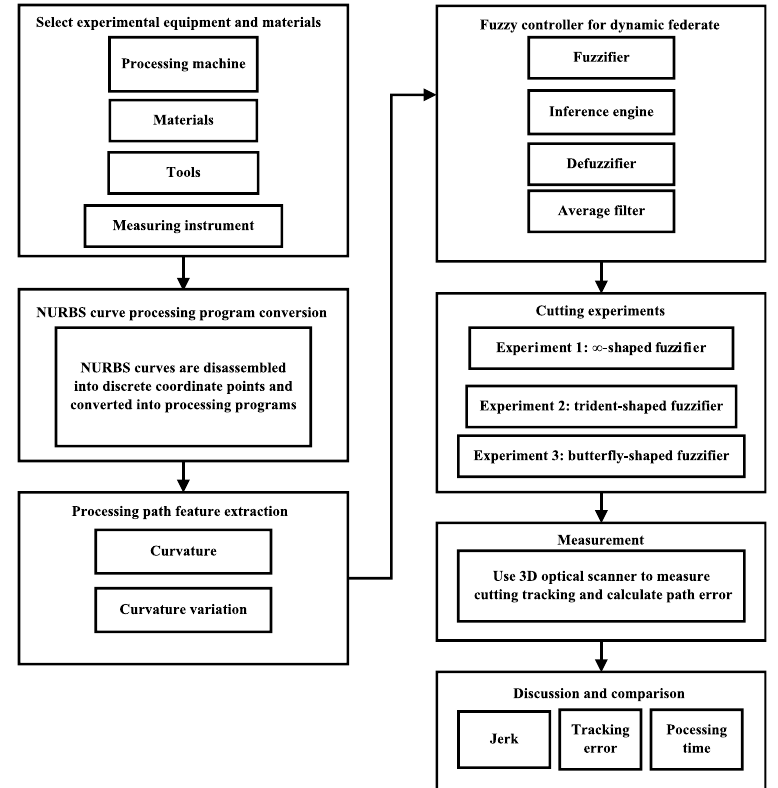
Figure 1. Procedure of fuzzy control for feed rate scheduling.